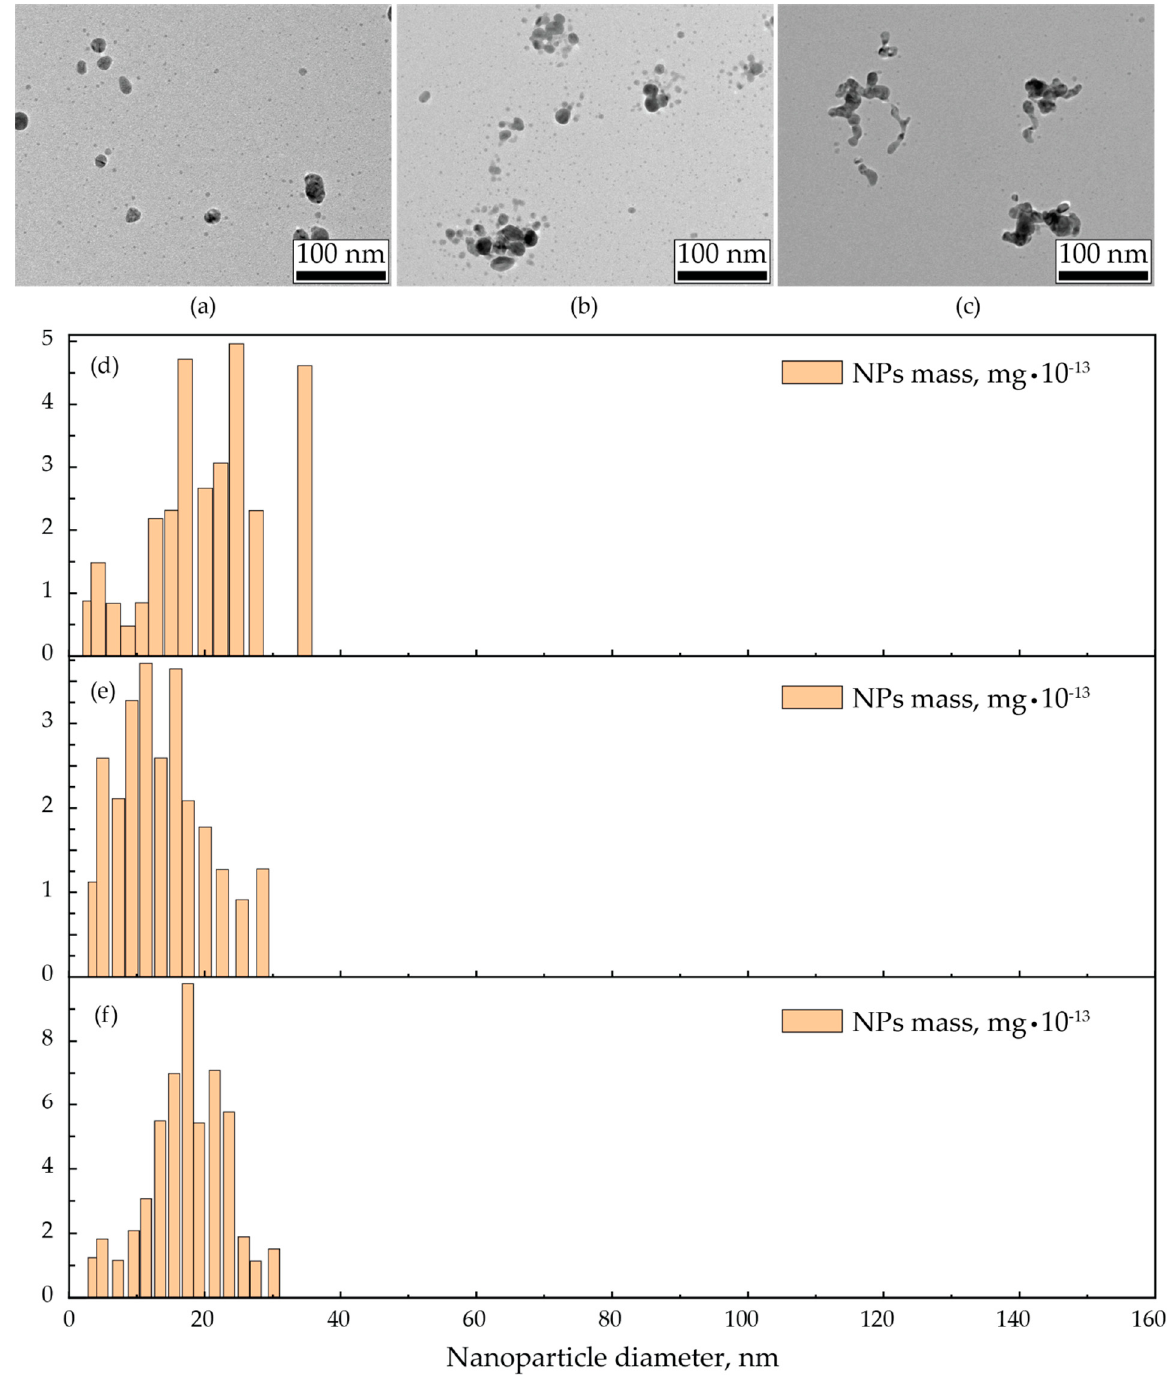
Figure 13. ( a – c ) TEM images and ( d – f ) mass-size NPs distributions for the cases of NP synthesis with the UDP for electrodes’ end faces arranged ( a , d ) in parallel and at angles ( b , e ) 3° and ( c , f ) 10°.